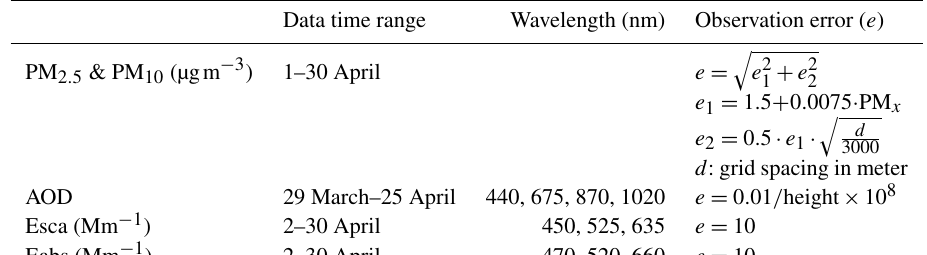
Table 1. The observed surface particle concentration, aerosol scattering coefficient (Esca), aerosol absorption coefficient (Eabs), and AOD used for the DA analysis and their observational errors.